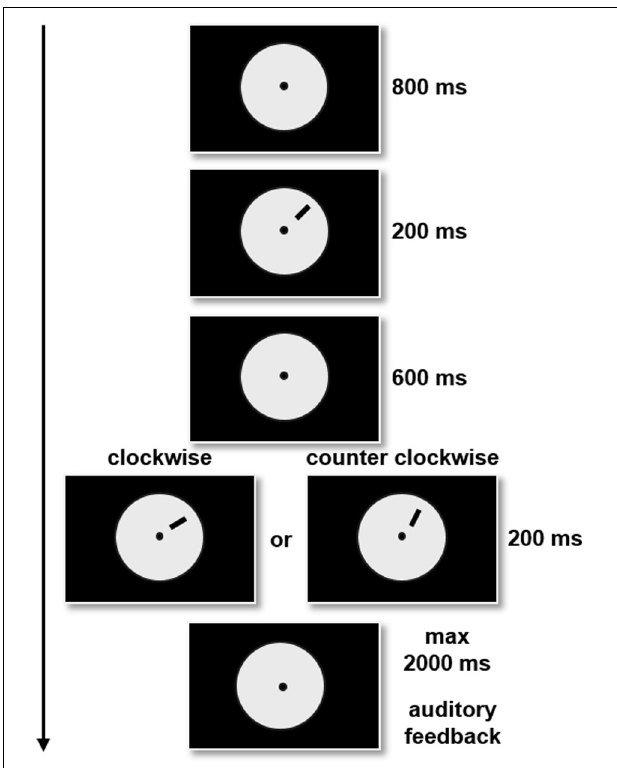
FIGURE 1 | Example of an ODT trial with the reference and target stimuli presented in the upper right hemifield. The line can turn clockwise or counter clockwise. The subjects were asked to decide whether the presented stimulus was tilted clockwise or counter clockwise relative to the previously presented stimulus.